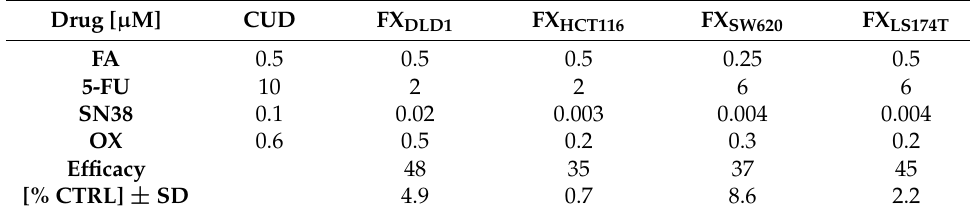
Table 2. FX doses used in this